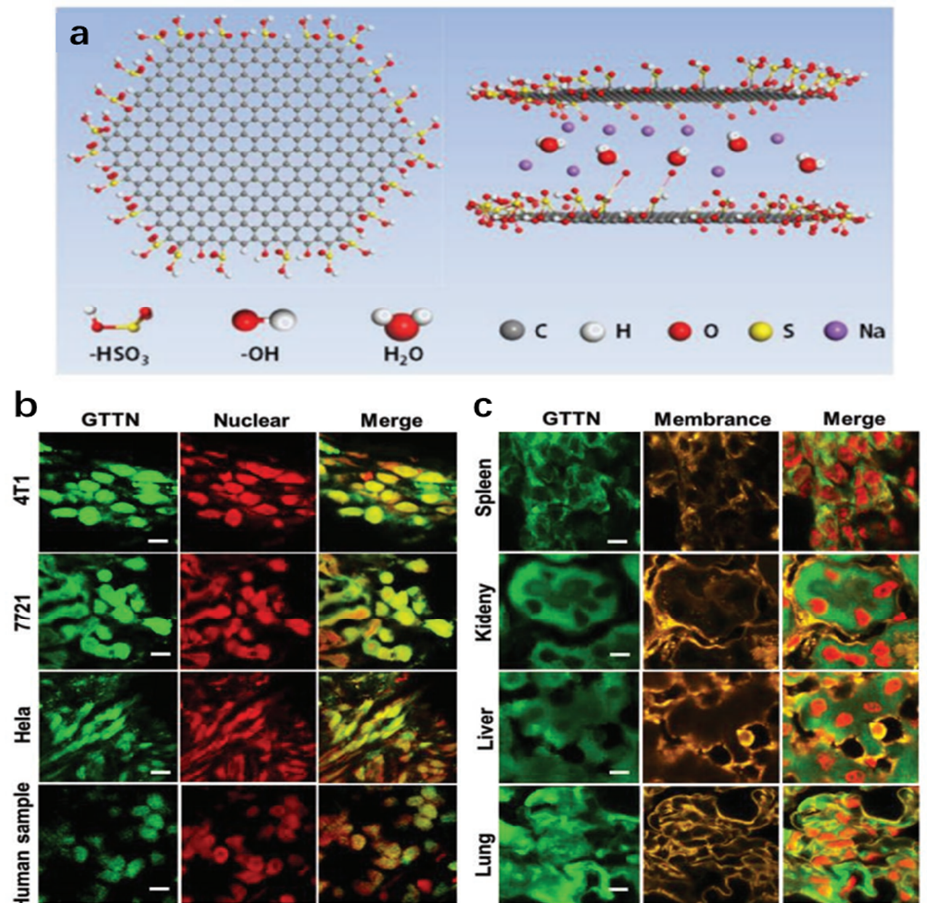
Figure 30. ( a ) The spatial structure of GTTN. ( b ) Tumor tissue frozen section of subcutaneous tumor model and human hepatoma tumor model. ( c ) Normal tissue frozen section of subcutaneous tumor model. Reproduced from [92] with permission from John Wiley and Sons, Copyright 2019. Table 3. Summary of characteristic properties of nucleus-targeted fluorescent probes for therapy.